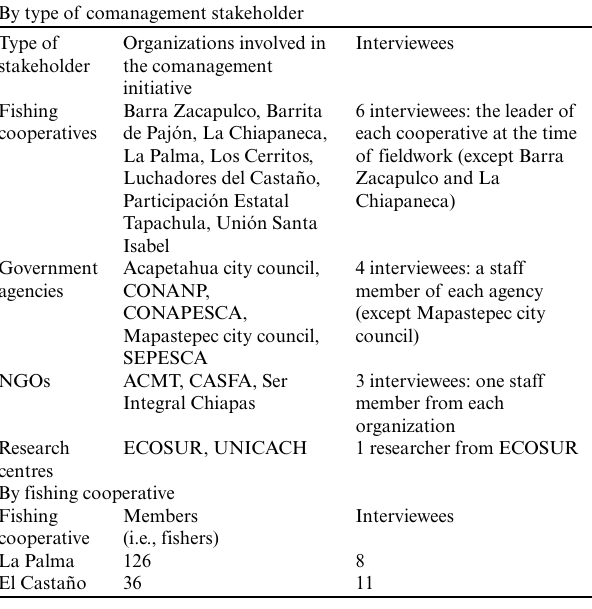
Table 1 . Sampling strategy for the mental models’